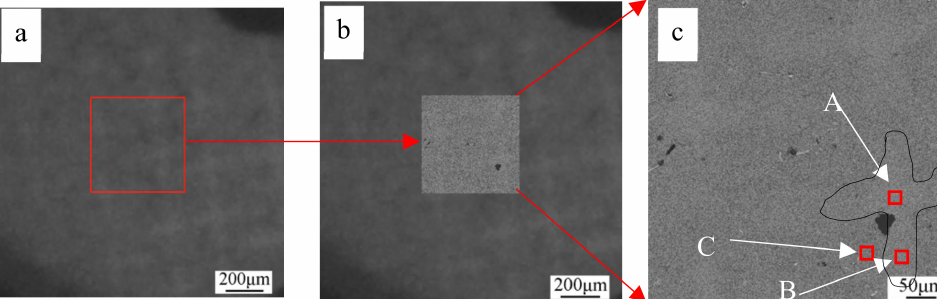
Figure 9. SEM image collection area and 3 typical locations. ( a ) The optical image of the single crystal blade, the red frame is the SEM image collection area ( b ) the SEM image corresponding to the position of the optical image, ( c ) Three typical positions determined based on optical images, where A, B and C correspond to primary dendrite arm, secondary dendrite arm and interdendrite,